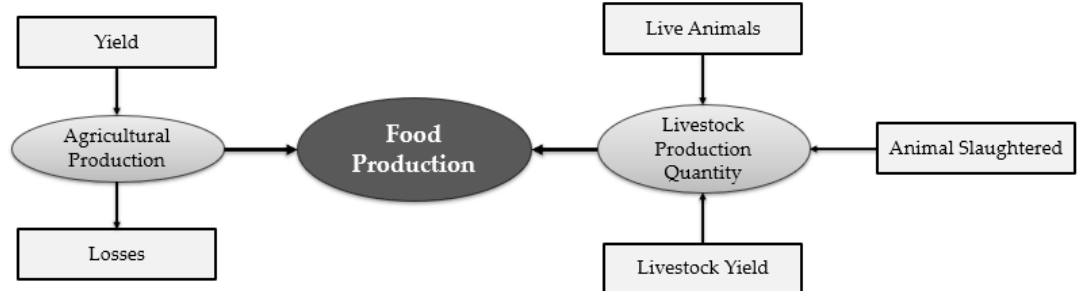
Figure 1. The proposed model of the study for indigenous food production in Iran.